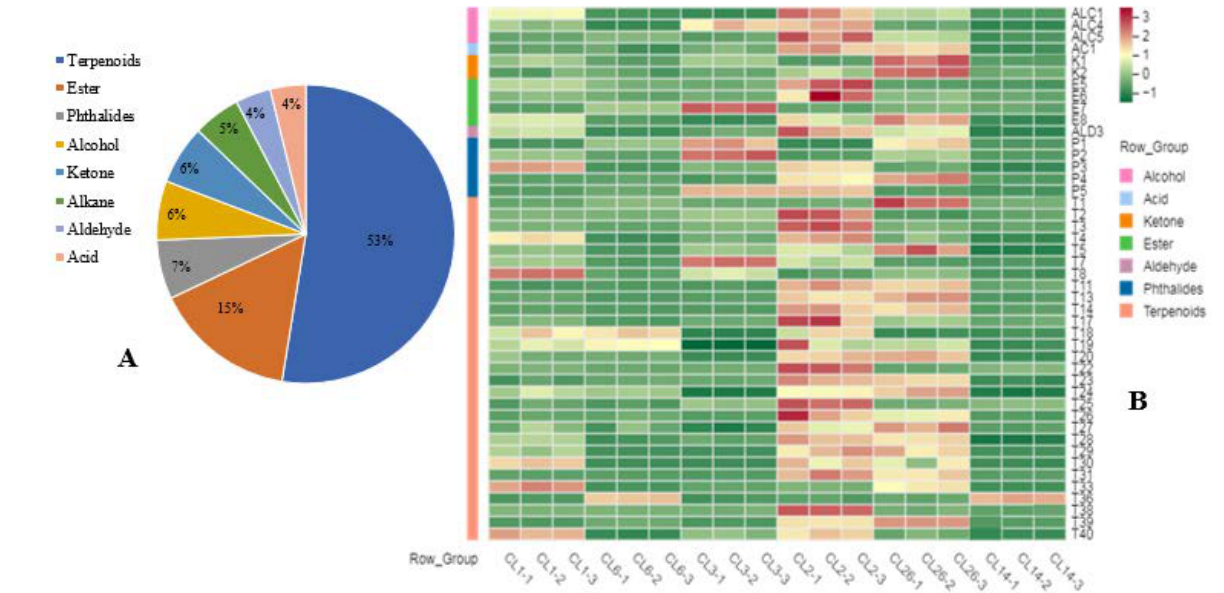
Figure 6. The classification of volatile compounds ( A ) and the heat map of relative content of different volatile flavor compounds ( B ) in celery juice. All the relative contents normalized using z-score. The abbreviations of different volatile flavor compounds were show in Table S8.